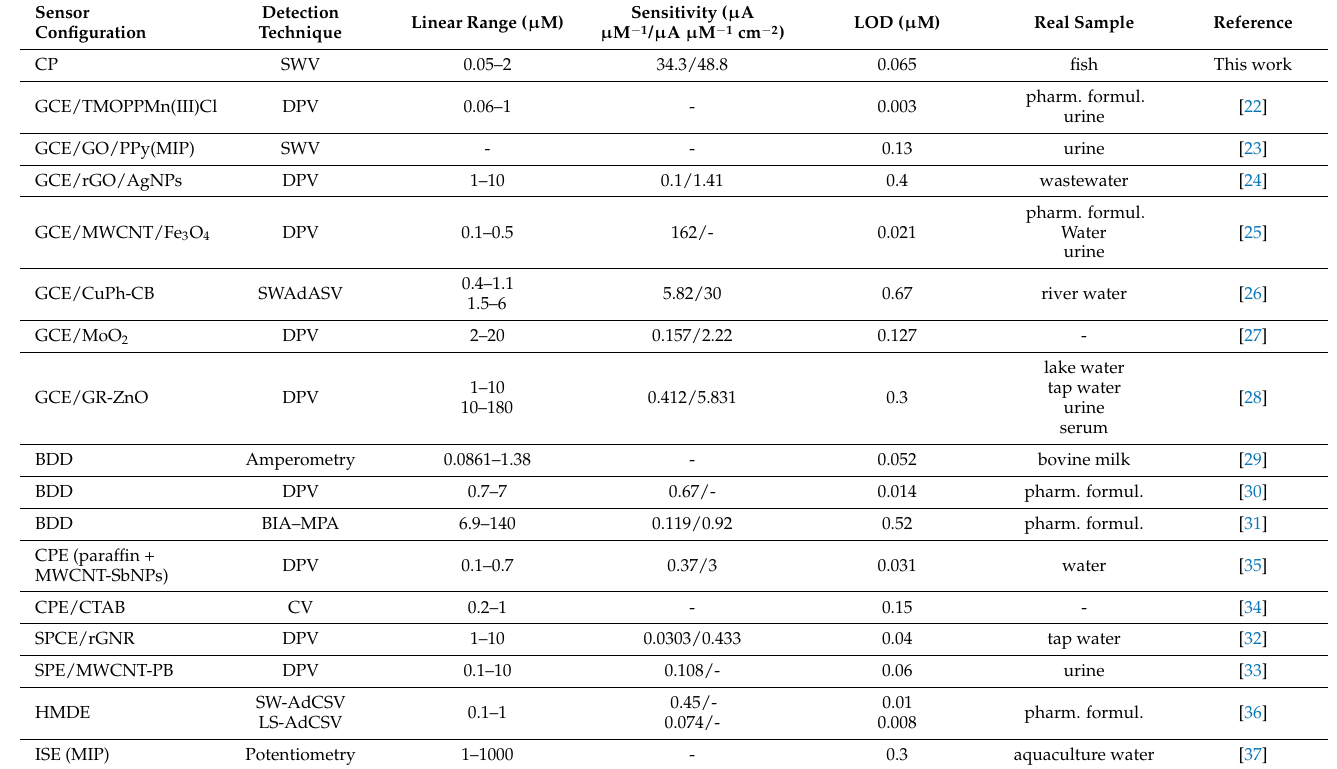
Table 1. Studies in the literature concerning trimethoprim electroanalysis. Sensor